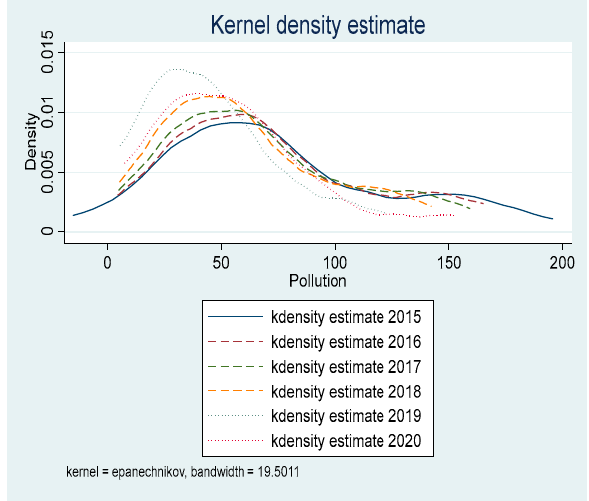
Figure 1. Dynamic evolution trend of environmental pollution.